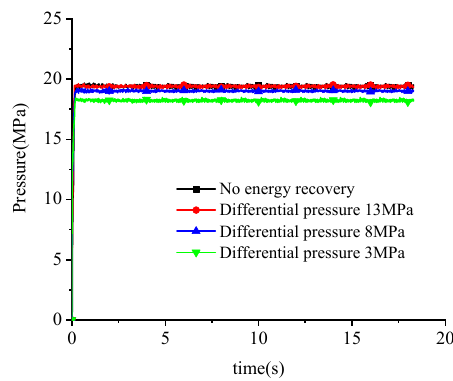
Figure 27. The input pressure of the relief valve under different pressure difference control.